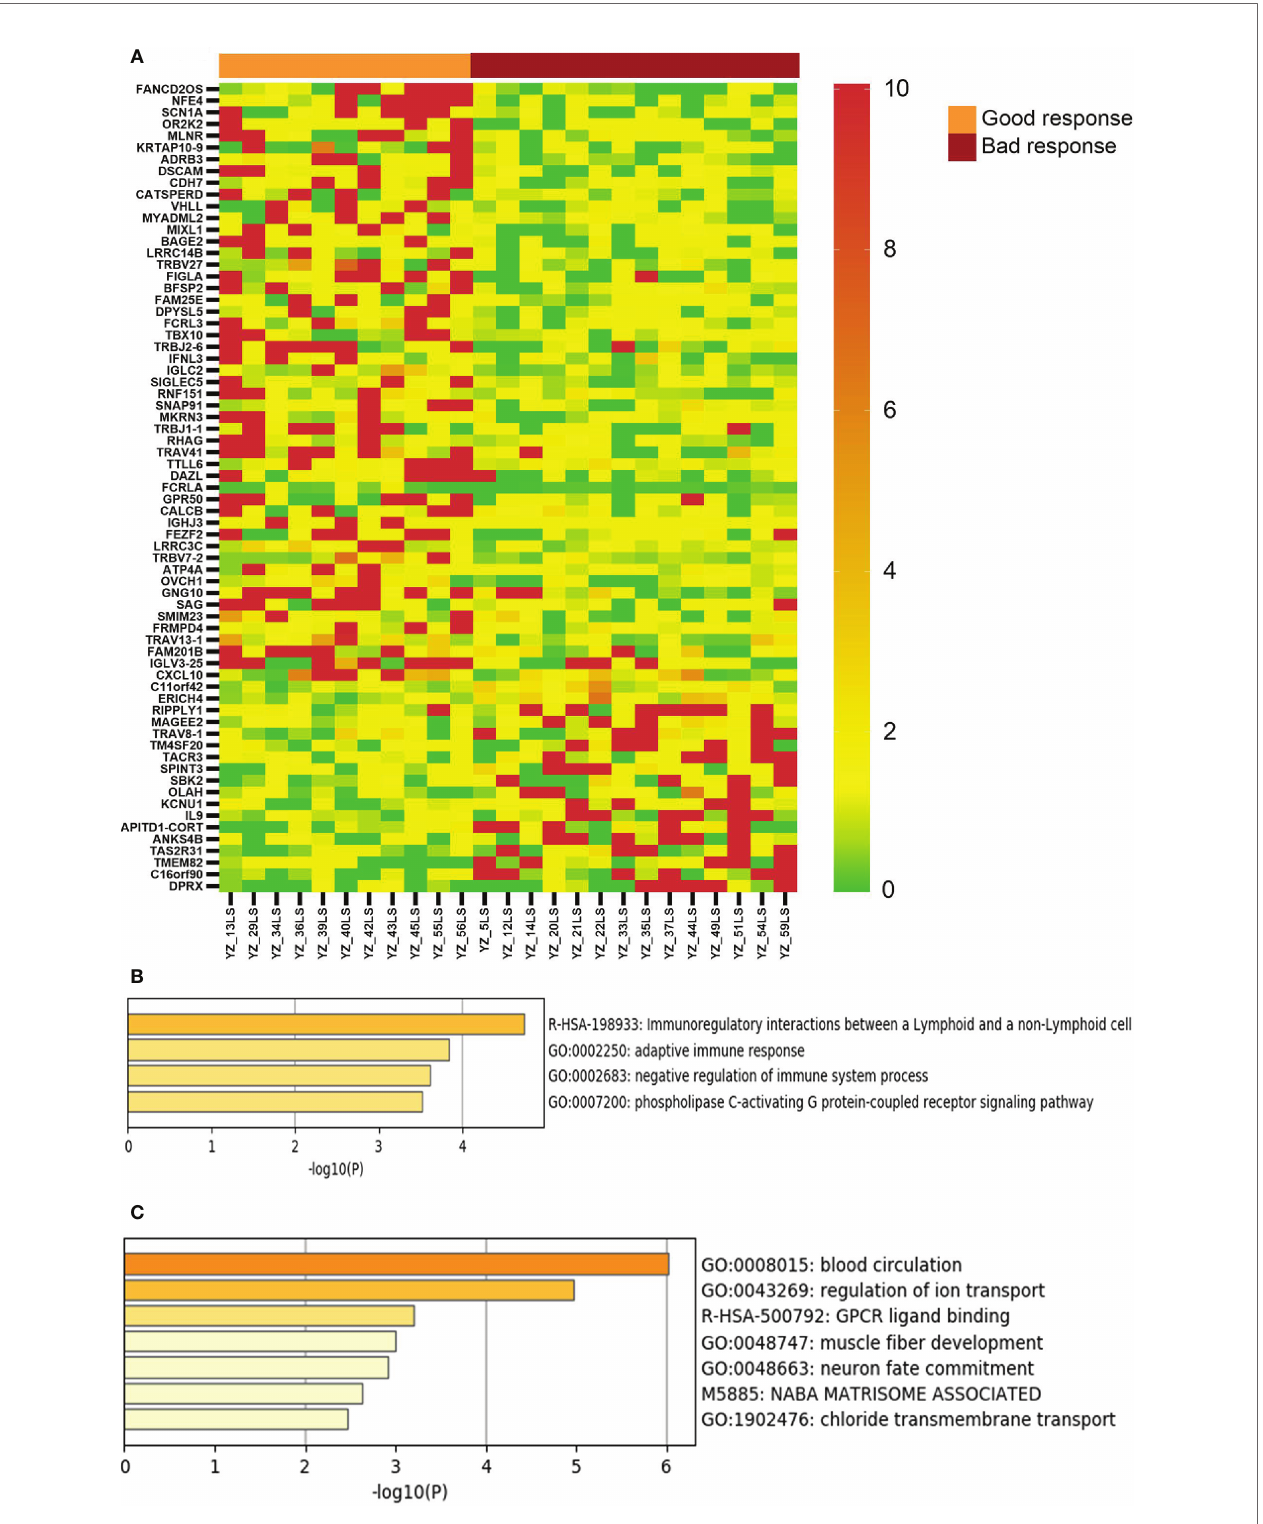
FIGURE 3 | Genes with differential expression between vitiligo lesions with favorable response and lesions with non-favorable response to therapy. (A) LS/NLS ratios of 69 genes showing >2 fold difference between good response and bac response lesions (p < 0.05); (B, C) Pathways represented by markers of good and bad response,